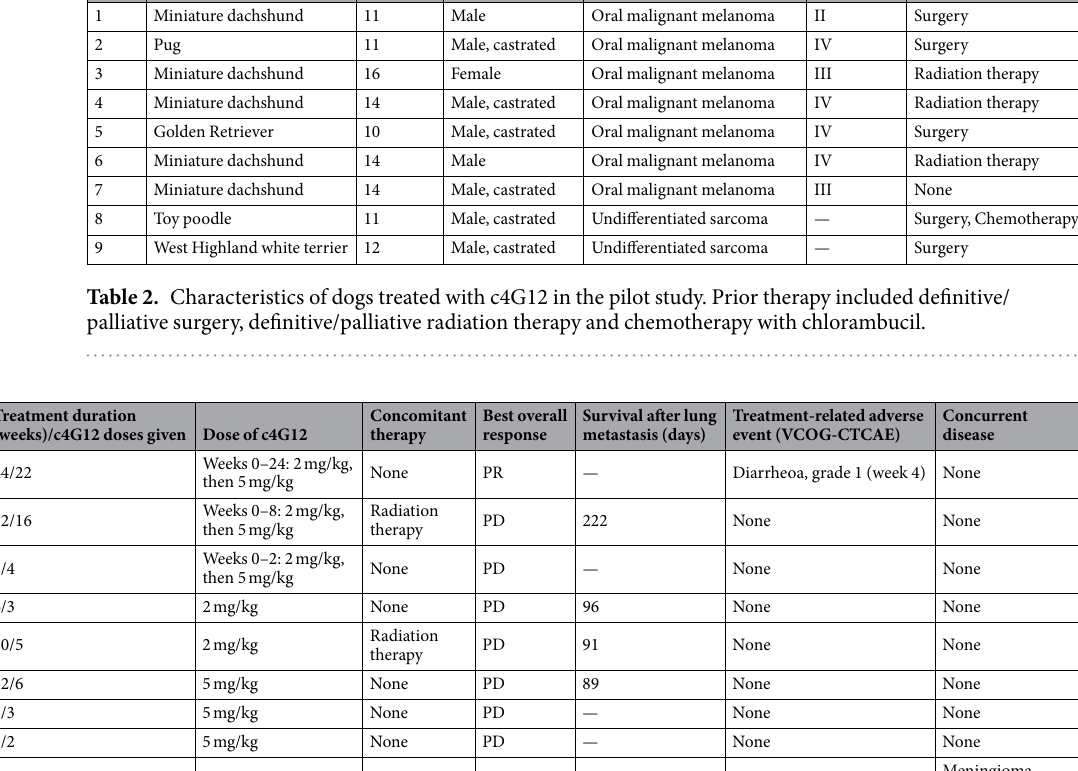
Table 3. Results of pilot study of dogs treated with c4G12. PR, partial response; PD, progressive disease. Adverse events which is possibly treatment-related are shown in the